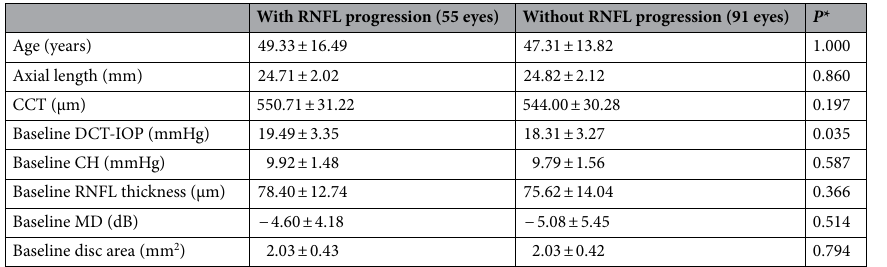
Table 3. Comparisons of baseline ocular biometry, visual field, optic nerve head (ONH), retinal nerve fiber layer (RNFL), corneal hysteresis (CH) and intraocular pressure (IOP) measurements (DCT-IOP) between eyes with and without RNFL progression with Cirrus HD-OCT. CCT—central corneal thickness; DCT-IOP— diastolic intraocular pressure; MD—mean deviation; CH—corneal hysteresis. *Comparisons were performed using Linear mixed modeling.